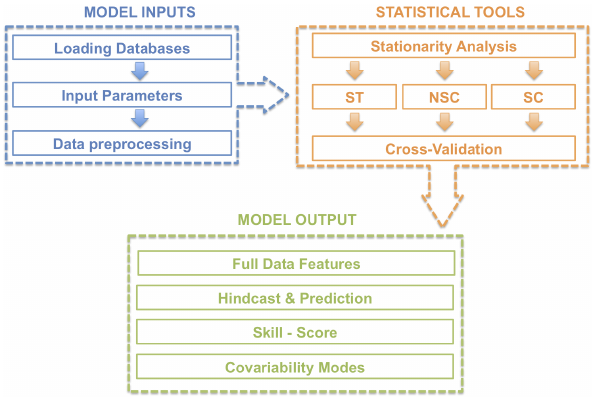
Figure 1. Schematic diagram illustrating the structure of the model.